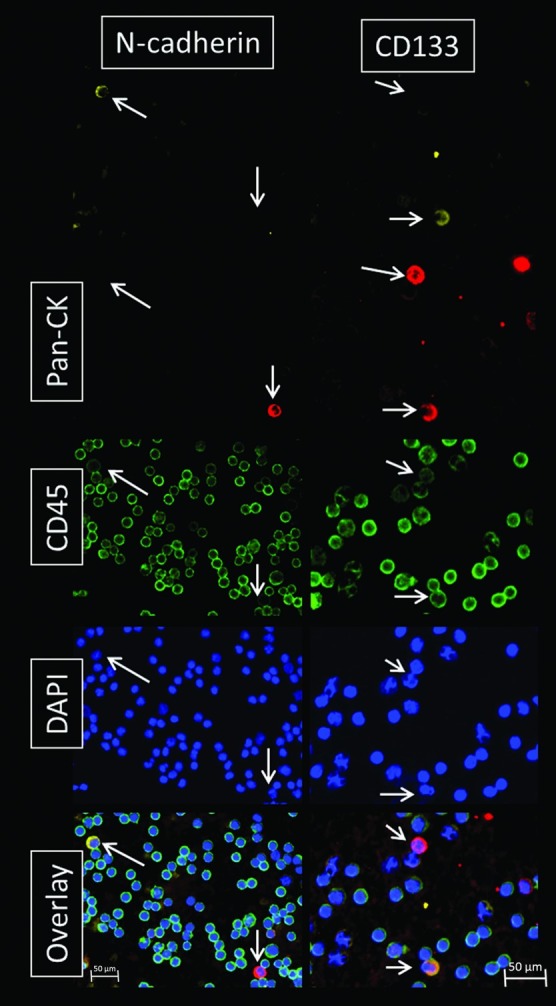
Detection of CTC subtypes.CTC isolated from mRCC patients were stained with DAPI (nucleus; blue) and for CD45 (hematopoietic; green), pan-CK (epithelial; red) and N-cadherin (mesenchymal; yellow) on one slide and with DAPI and for CD45, pan-CK and CD133 (stem cell; yellow) on a second slide. Cells marked with a white arrow were considered as CTC. The image displays various CTC subtypes with epithelial, mesenchymal and/or stem cell-like features such as N-cadherin+/CK-/CD45-; N-cadherin-/CK+/CD45-; CD133+/CK+/CD45+ and CD133-/CK+/CD45 (low) cells.